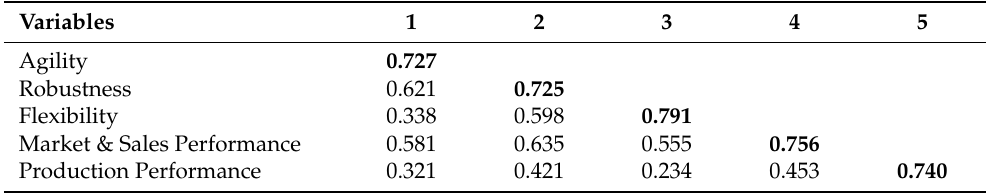
Table 5. Discriminant